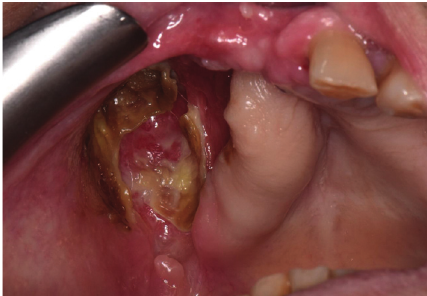
Figure 4: Patient’s clinical condition at 2-month follow-up visit: persistence of oroantral communication and presence of mucus.